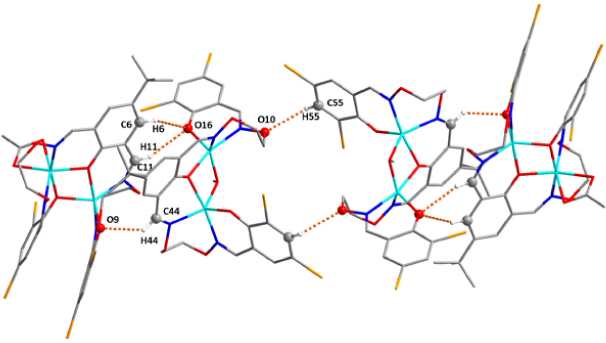
Figure 4. The 0D dimer structure of the coordination compound 2 with inter-molecular hydrogen bondings (hydrogen atoms, except those forming hydrogen bonds, are omitted for